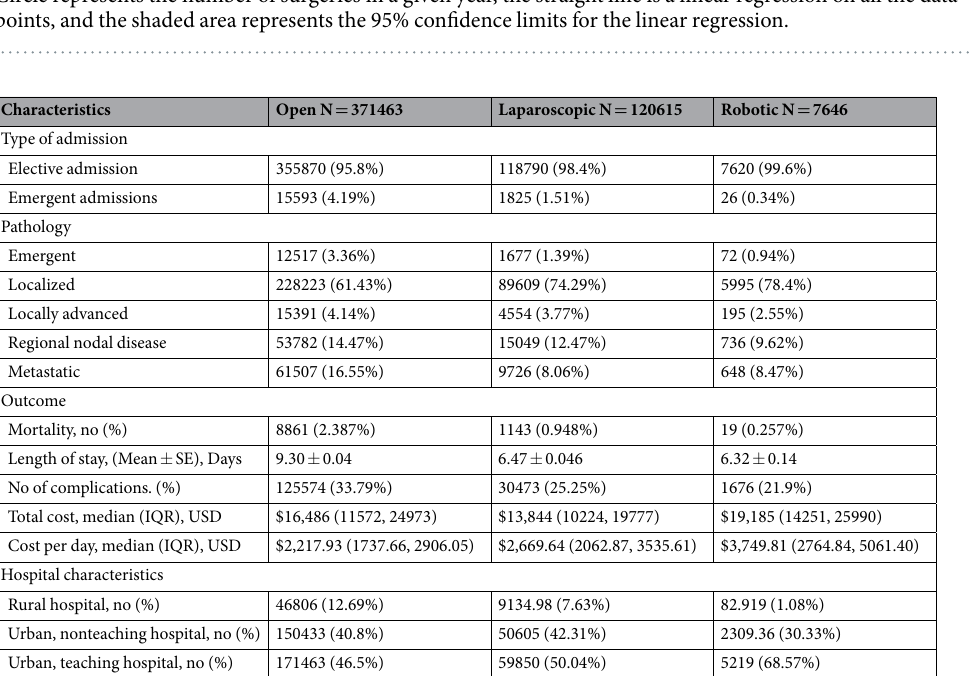
Table 2. Characteristics and outcomes of 3 different types of colorectal surgeries from